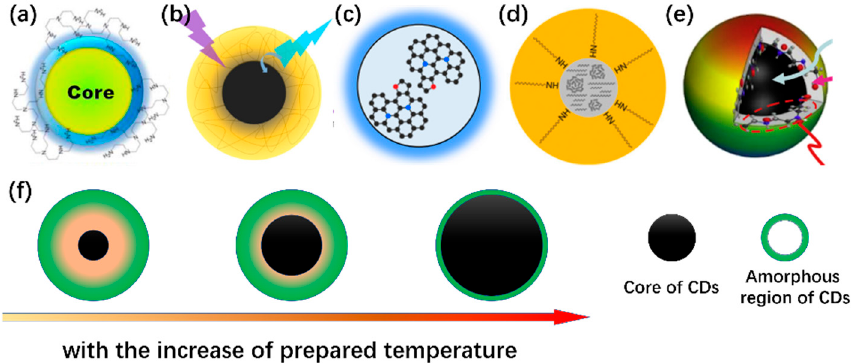
Figure 5. ( a – e , Ref. [50–54]) Different models of CD structure diagrams. ( f ) Structure changes of CDs with the increase of temperature during the carbonization step. Reproduced from Ref. [50–54] with permission of Copyright (2012) American Chemical Society, Copyright (2015) Springer, Copyright (2017) Nature Publishing Group, Copyright (2014) John Wiley and Son, and Copyright (2017) Elsevier, respectively.